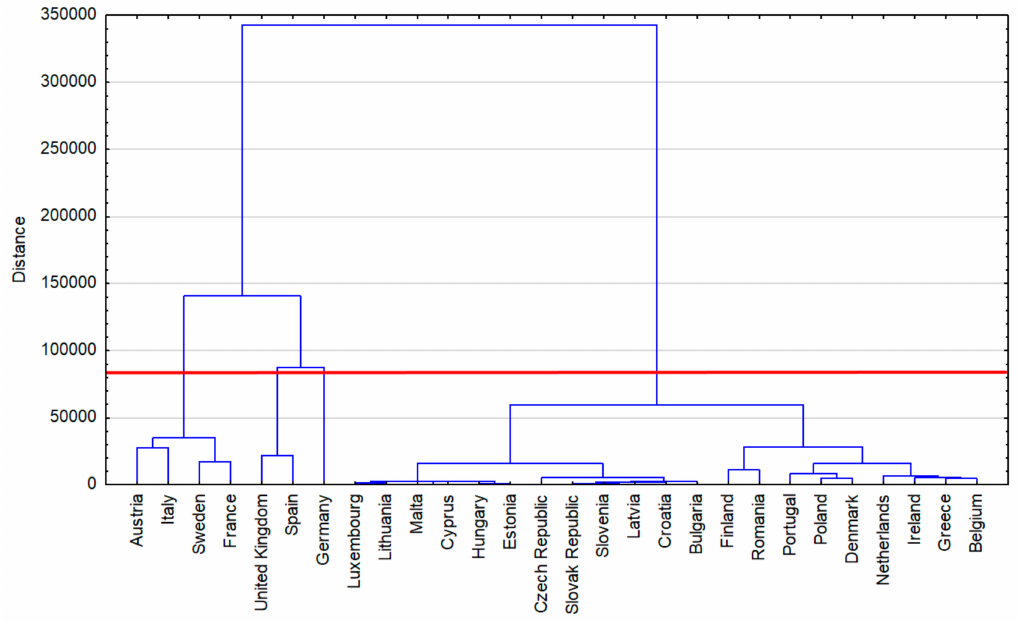
Figure 9. Results of the hierarchical grouping of similarities between the EU countries in energy production from renewable energy sources in 2017 using the Ward’s method (own study).